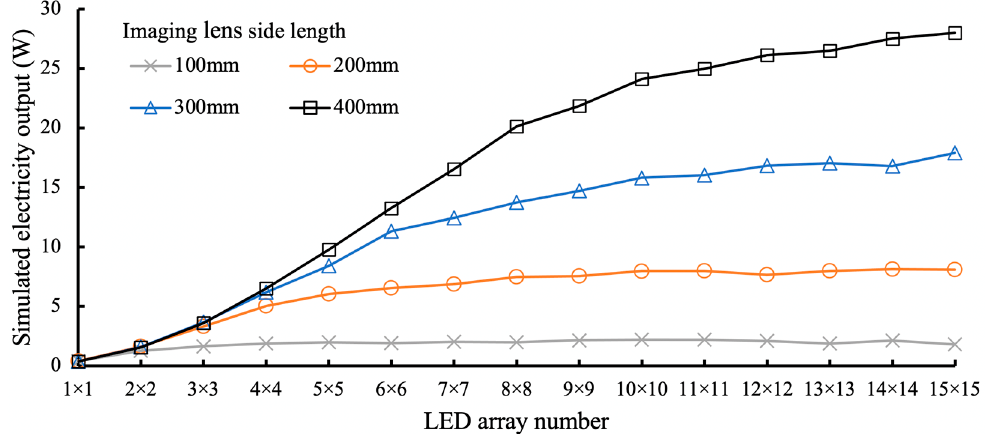
Figure 9. Relation between imaging lens aperture and the corresponding electricity output. The gray curve with cross marks is the simulated electricity output of the 100 × 100 mm 2 imaging lens condition, which is consistent with the solid curve in Figure